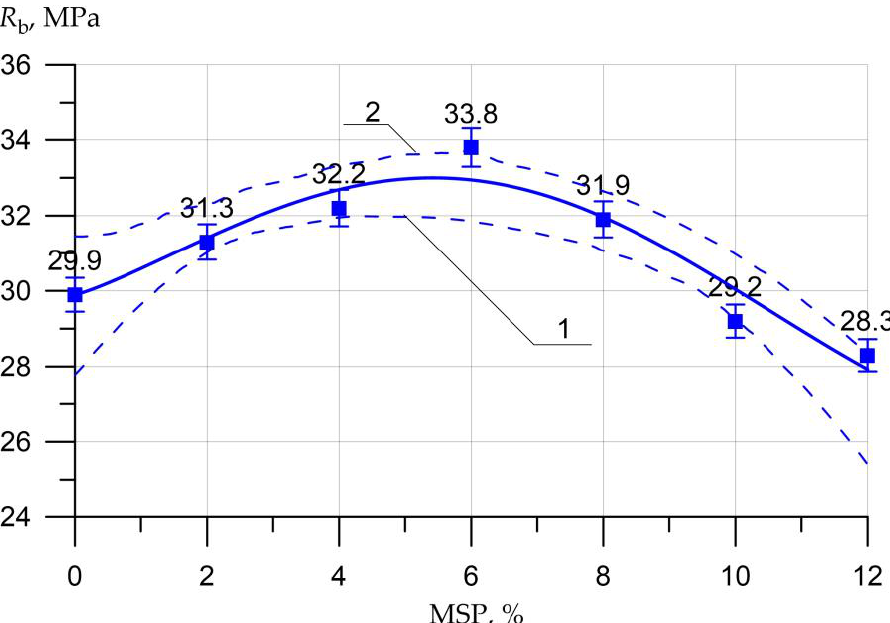
Figure 6. Dependence of the axial CS of concrete R b on the amount of MSP: 1 — lower confidence level; 2 — upper confidence level.